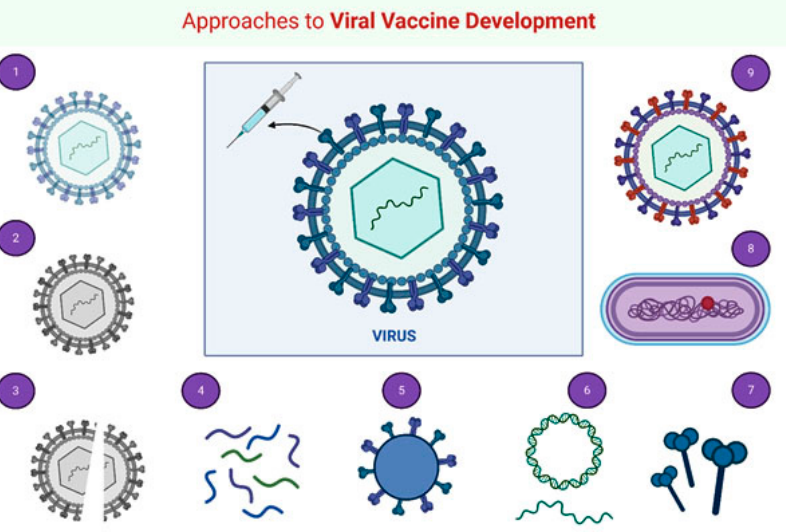
Fig. 1. Schematic illustration of frontiers in viral vaccine development approaches. 1 - Live attenuated, 2 - Whole inactivated, 3 - Split inactivated, 4 - Synthetic peptides, 5 - Virus-like particles, 6 - DNA or RNA, 7 - Recombinant subunits, 8 - Recombinant bacterial vectors, and 9 - Recombinant viral vectors. The ¬Figure was created with “BioRender.com” template and exported under the terms of premium